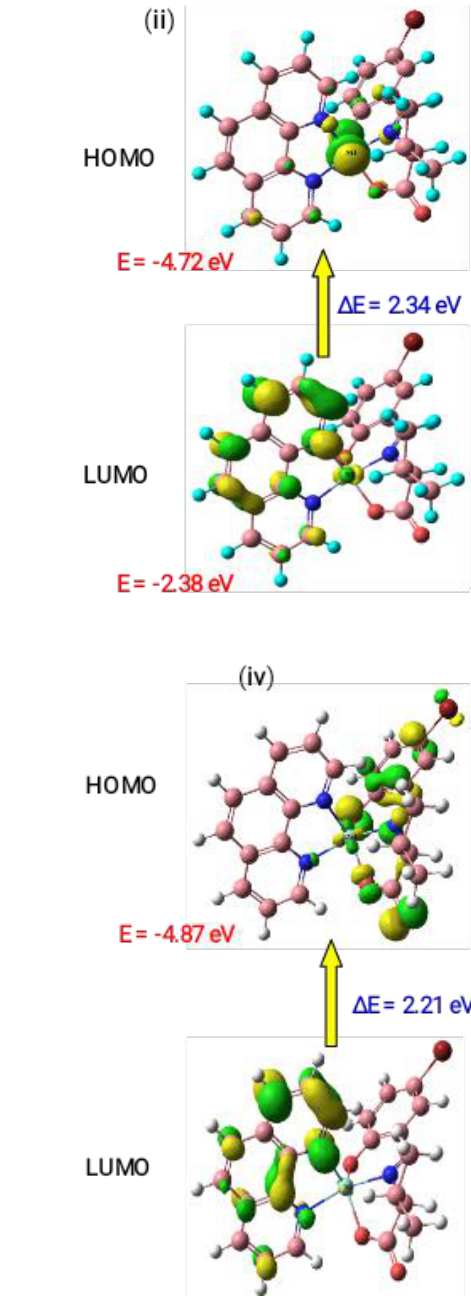
Figure 6. Frontier molecular orbitals of investigated complexes, namely, ( i ) cobalt(II) complex 1a , ( ii ) nickel(II) complex 1b , ( iii ) copper(II) complex 1c , and ( iv ) zinc(II) complex 1d , using B3LYP/LACVP++ basis set.